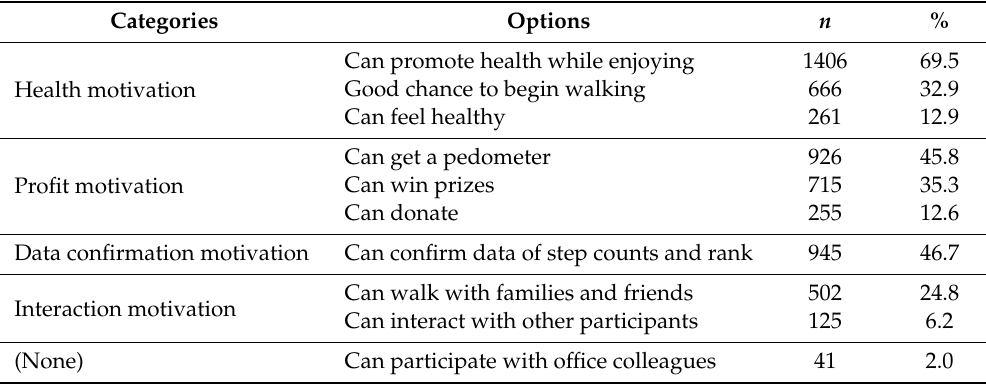
Table A2. Motivation for participation in YWPP (multiple